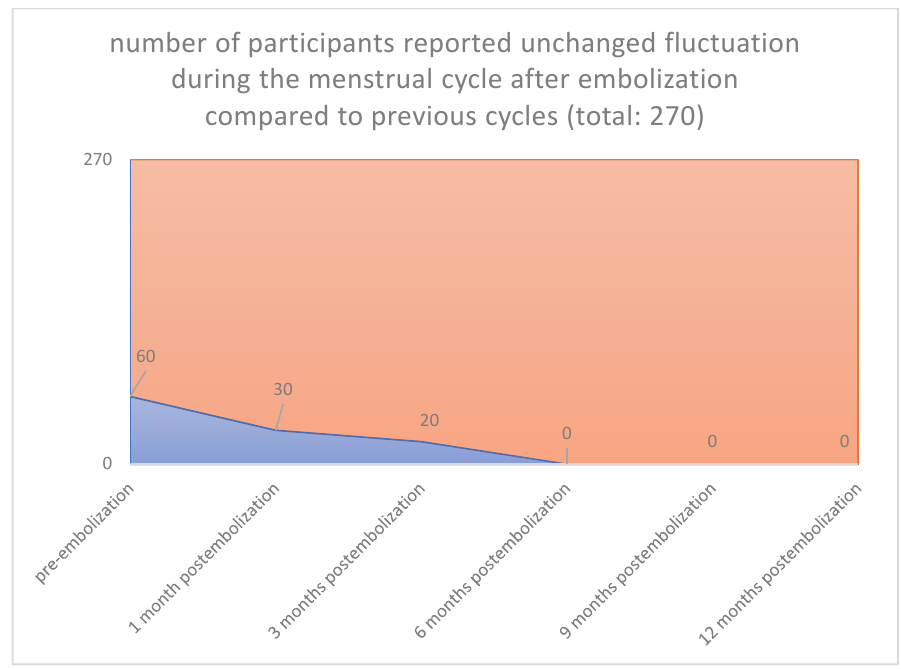
Figure 3. The fluctuation during the menstrual cycle: Pre-embolization 60 from 270 participants re- ported fluctuation during the menstrual cycle. 1 Month 30 from 60 participants reported un- changed fluctuation during the menstrual cycle. 3 Months 20 from 60 participants reported fluctu- ation during the menstrual cycle. 6 Months 0 from 60 participants reported unchanged, but signif- icantly reduced fluctuation during the menstrual cycle. 9 Months 0 from 60 participants reported unchanged flatulence, but significantly reduced pelvic floor heaviness, frequent urination during the menstruation’s day. 12 Months0 from 60 participants reported unchanged flatulence, but sig- nifi-cantly reduced fluctuation during the menstrual cycle.